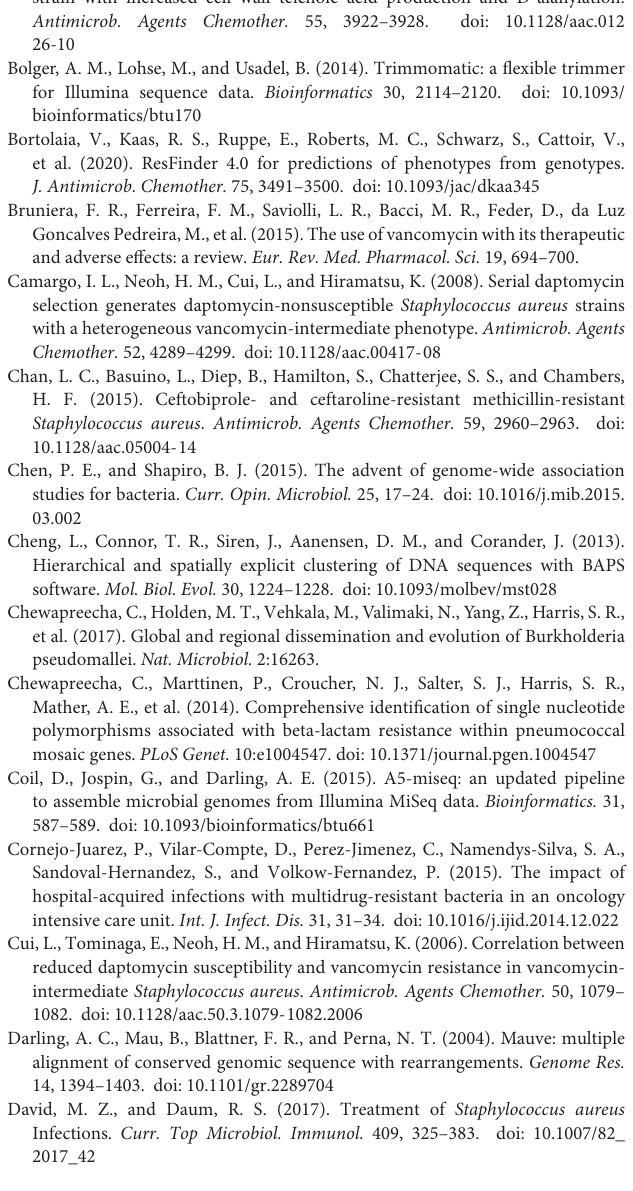
Supplementary Table 4 | PLINK defined population outliers. Supplementary Table 5 | Detection of GrlA S80F and GyrA